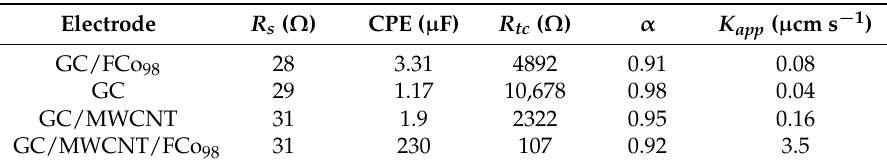
Table 1. Data obtained through the spectra of the complex